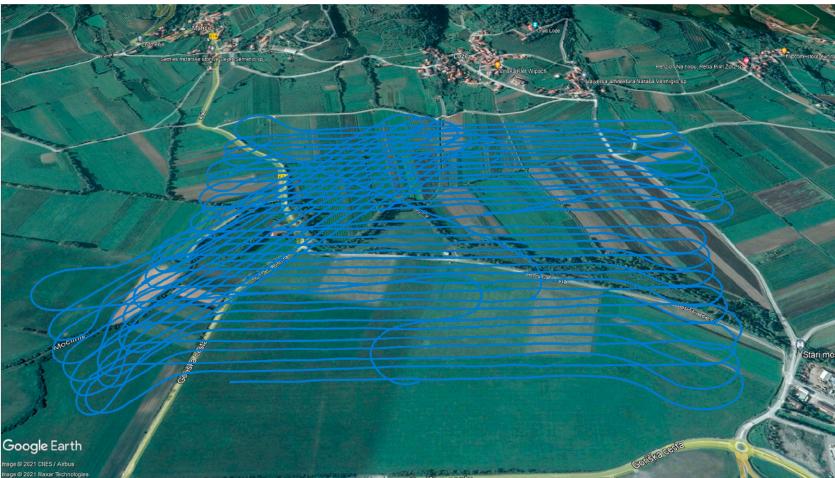
Figure 18. Flightpath of the flight performed on 3 September